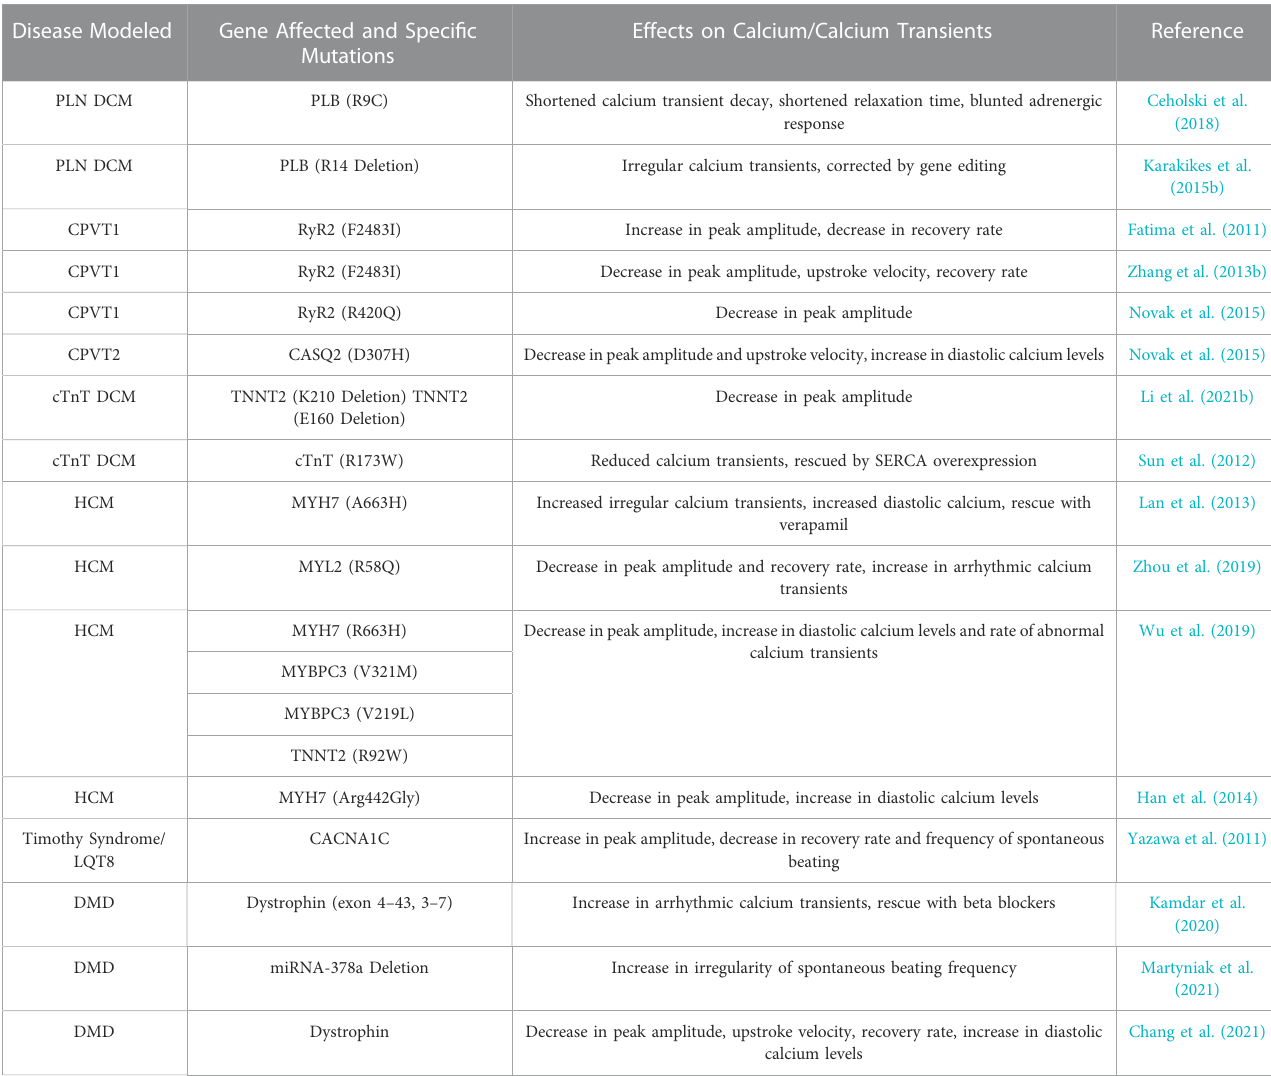
TABLE 2 Summary of hiPSC calcium changes in cardiovascular disease